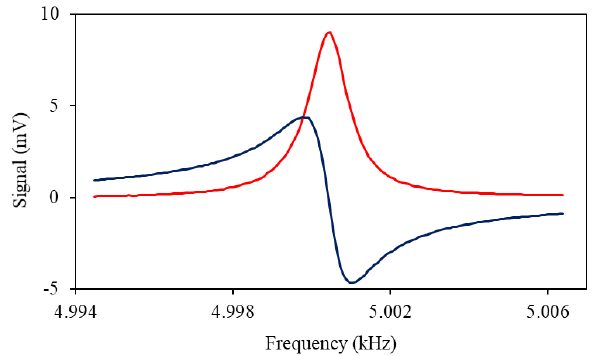
Figure 2. Recorded rf spectrum, consisting of the two quadrature lock-in amplifier